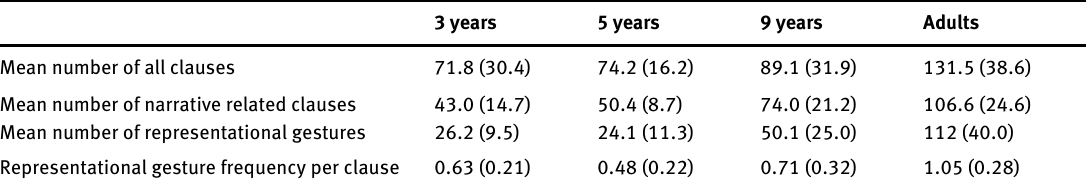
Table 1. Mean number and standard deviations (in parentheses) of clauses and representational gestures produced over 10 video clips.